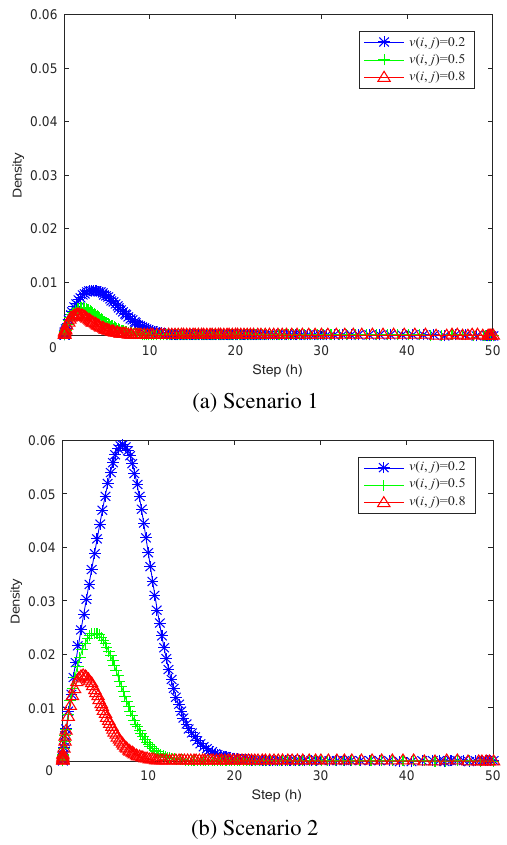
Fig. 8 Densities of dissemination nodes with different values of ˇˇˇ . Fig. 9 Densities of immune nodes with different values of (cid:29)(cid:29)(cid:29)